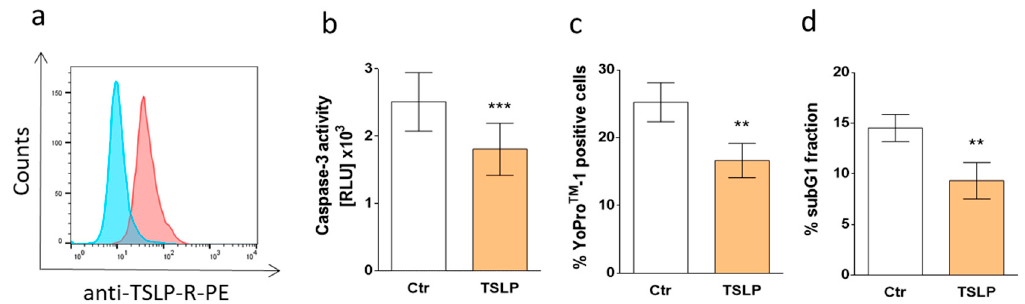
Figure 7. ( a ) Representative flow cytometry histogram of TSLP receptor (TSLPR) surface expression on skin MCs ex vivo (one representative out of four independent stainings is depicted) ; blue: Isotype control; red: anti-TSLPR. ( b – d ) TSLP counters apoptosis of skin MCs ex vivo. Freshly isolated skin MCs were kept without or with TSLP (at 0.35 ng / mL) in serum / GF-free medium. ( b ) Caspase-3 activity as determined after 24 h by Caspase-Glo ® 3 / 7 assay; the results represent the mean ± SEM of six independent experiments. RLU = relative luminescence units ( × 10 3 ). ( c , d ) percentage of cells with ( c ) YoPro TM -1 positivity (corresponding to the percentage of early and late apoptotic / necrotic cells combined) after 48 h or ( d ) fragmented DNA (PI staining, corresponding to the percentage of subG1 positive cells) after 48 h. The results represent the mean ± SEM of five independent experiments. The data were analyzed by paired t -test, ** p < 0.01, *** p < 0.001.